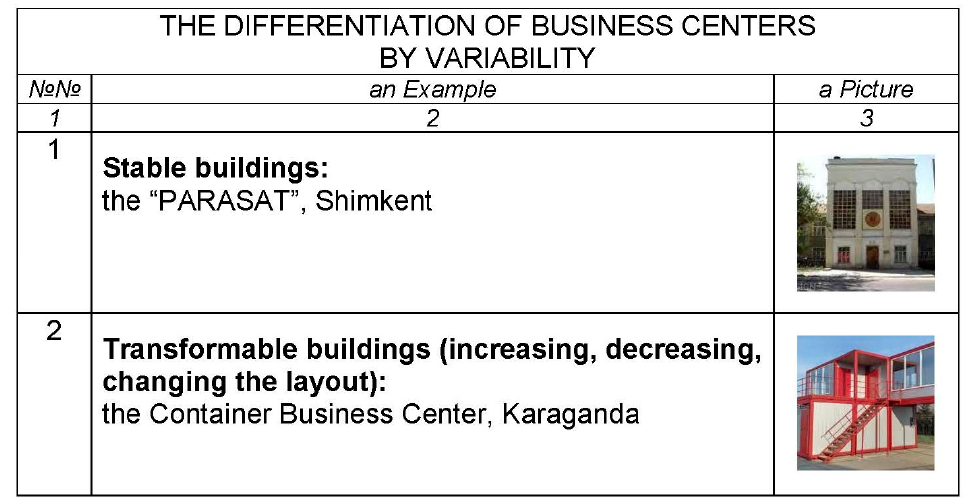
Figure 19. The differentiation of business centers by variability: ( 1 ) the PARASAT, Shymkent [138]; and ( 2 ) the Container Business Center, Karaganda [139].